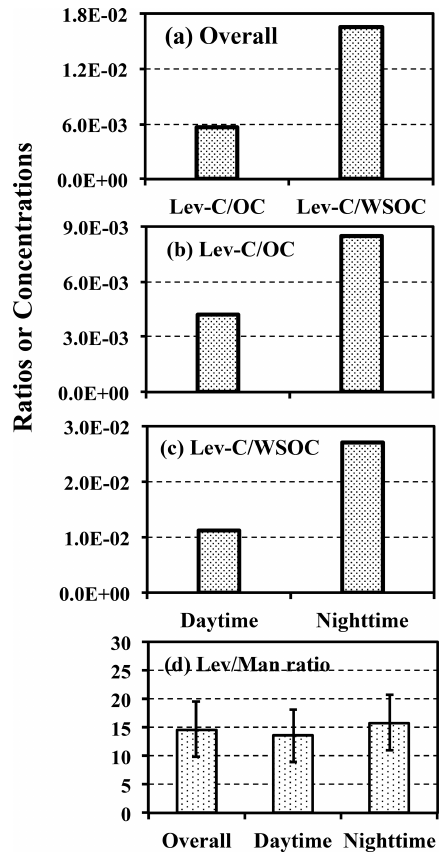
Figure 10. Mass concentration ratio of carbon contents of (a) lev- oglucosan (Lev) to organic carbon (OC) and water-soluble organic carbon (WSOC), (b) levoglucosan (Lev) to organic carbon (OC) daytime and nighttime, (c) levoglucosan (Lev) to water-soluble organic carbon (WSOC) daytime and nighttime, and (d) aver- age levoglucosan-to-mannosan ratios (Lev / Man) in the Mangshan aerosol samples for autumn